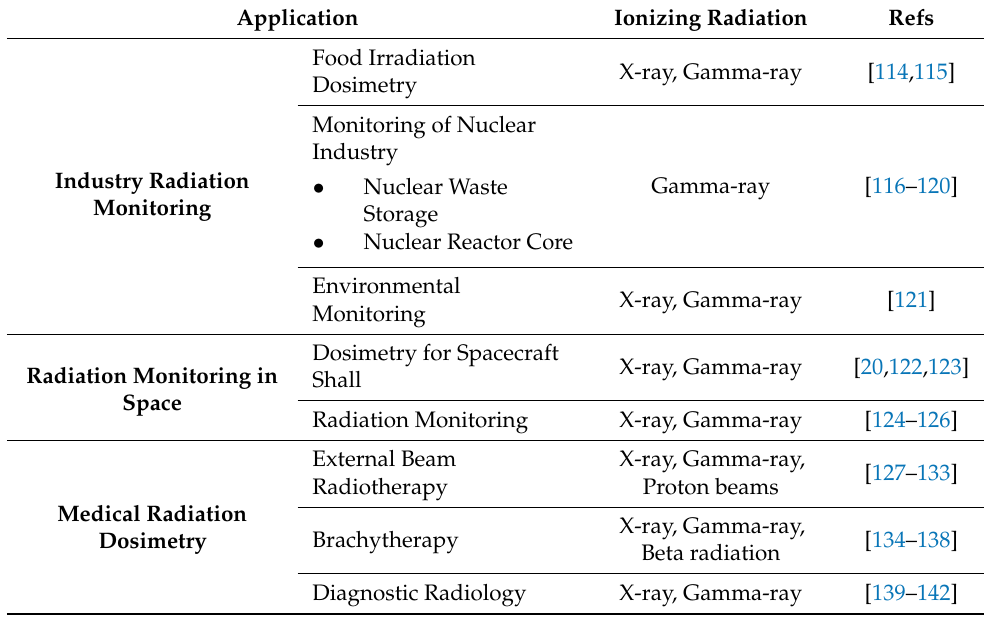
Table 2. Applications of Optical Fiber Radiation